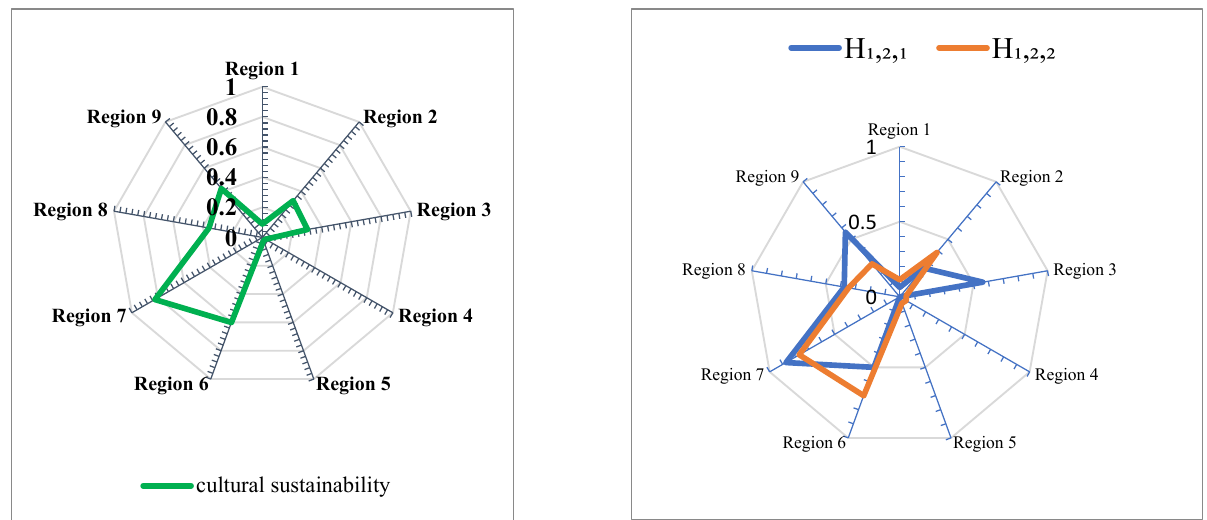
Figure 10. Cultural evaluation of the 9 regions: H 1,2,1 (Cultural places = 48–51), H 1,2,2 (Religious places = 52–53).